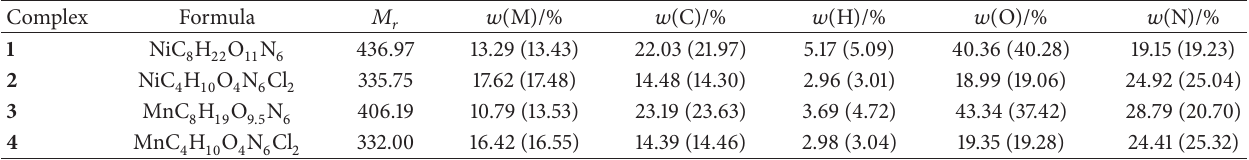
Table 1: Elemental analysis results of the complexes (calculated values are in